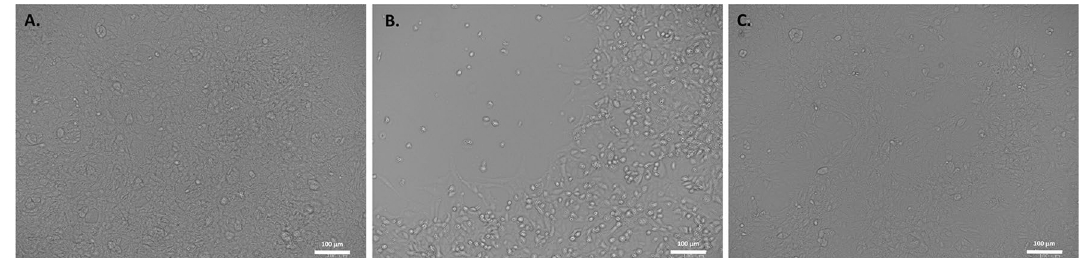
Figure 3. Analyses of virus induced cytopathic effect. ( A ) No cytopathic effect was observed in uninfected cultured VeroE6 monolayers maintained in 50 mJ/cm 2 UV-treated complete medium for 72 h. ( B ) In vitro infection of SARS-CoV-2 (5 MOI) UV-C untreated VeroE6 cells resulted in an evident cytopathic effect. ( C ) SARS-CoV-2 irradiation with 3.7 mJ/cm 2 UV-C rescued the cytopathic effect induced by UV-C untreated